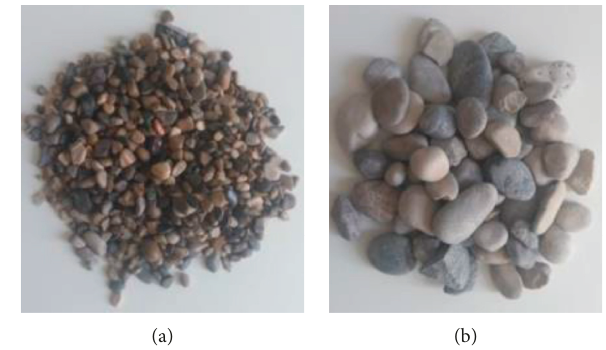
Figure 1: Used fractions of pebbles. (a) 4–8mm. (b) 16–32mm.